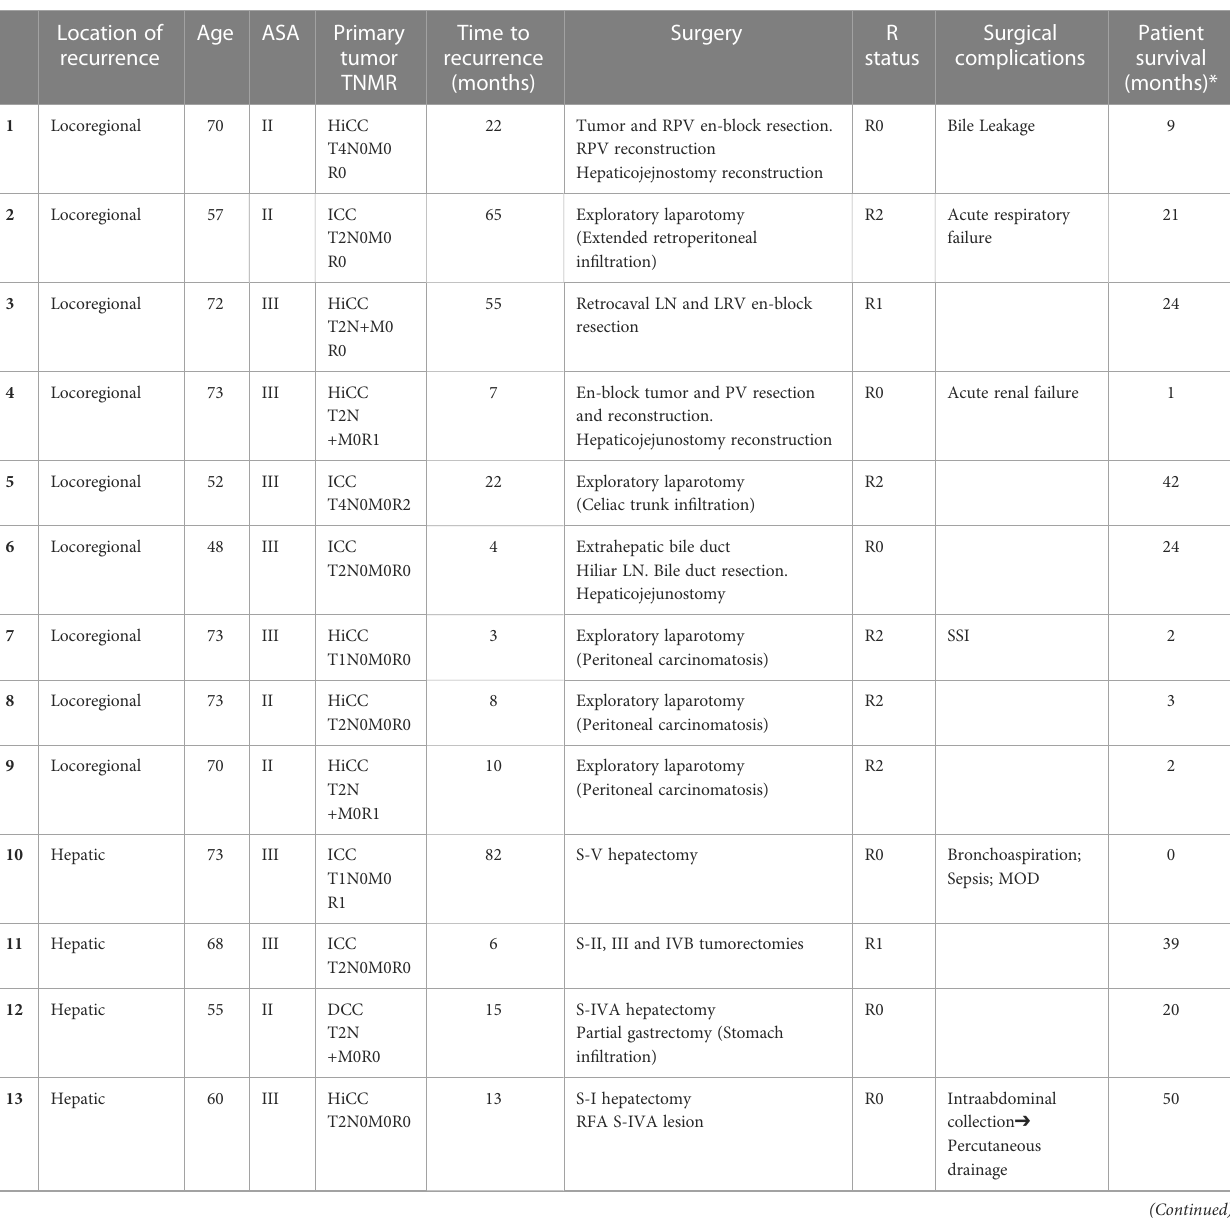
TABLE 2 Patients with surgical treatment for cholangiocarcinoma